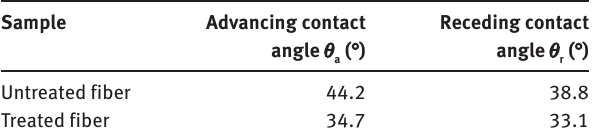
Table 2: Contact angle of PVA fiber. Sample